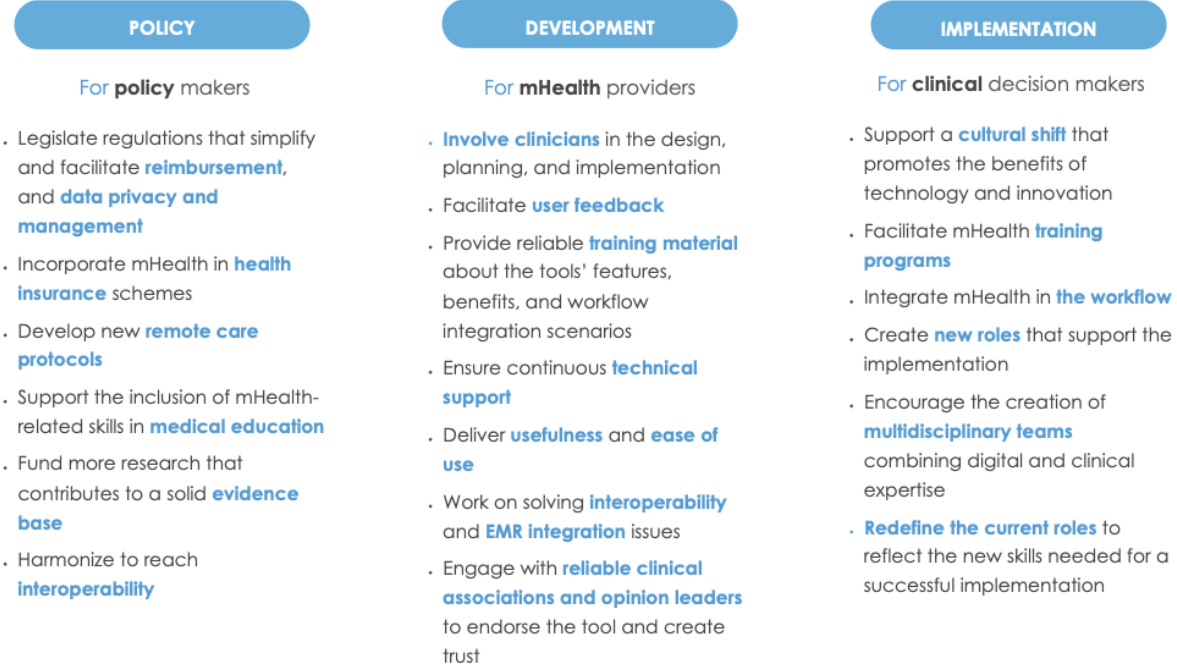
Figure 5. Implications for social and organizational practices. EMR: electronic medical